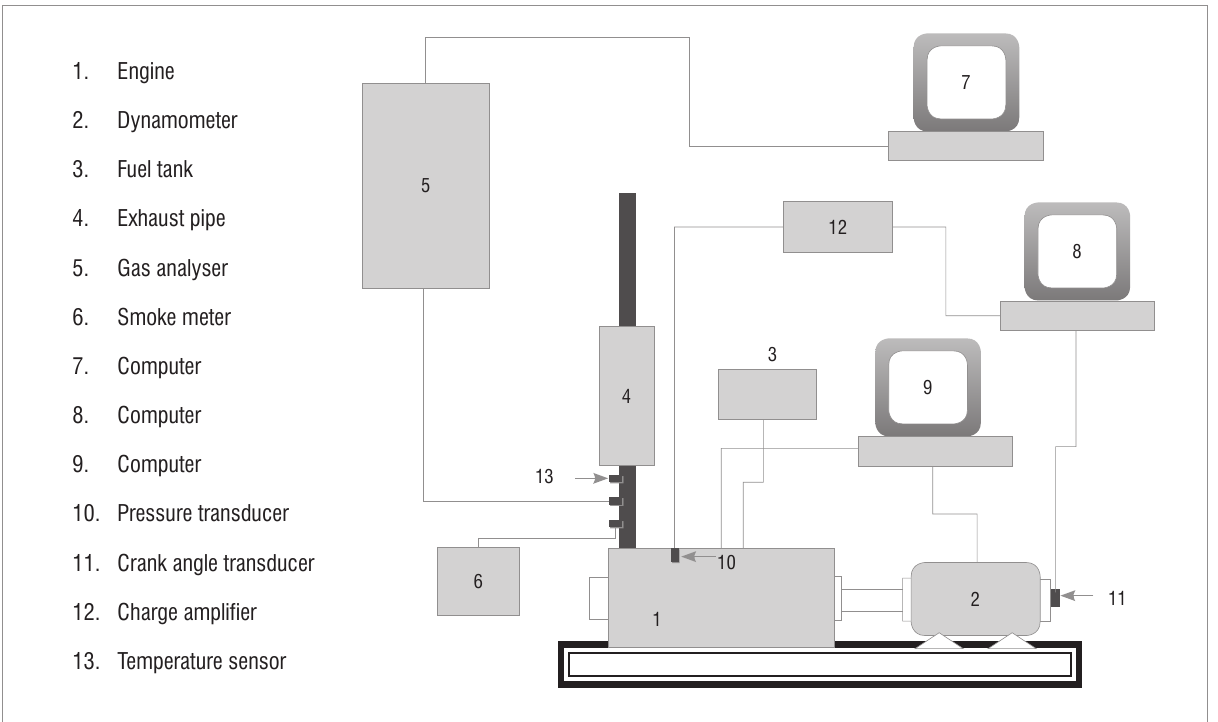
Figure 1: Engine test experimental